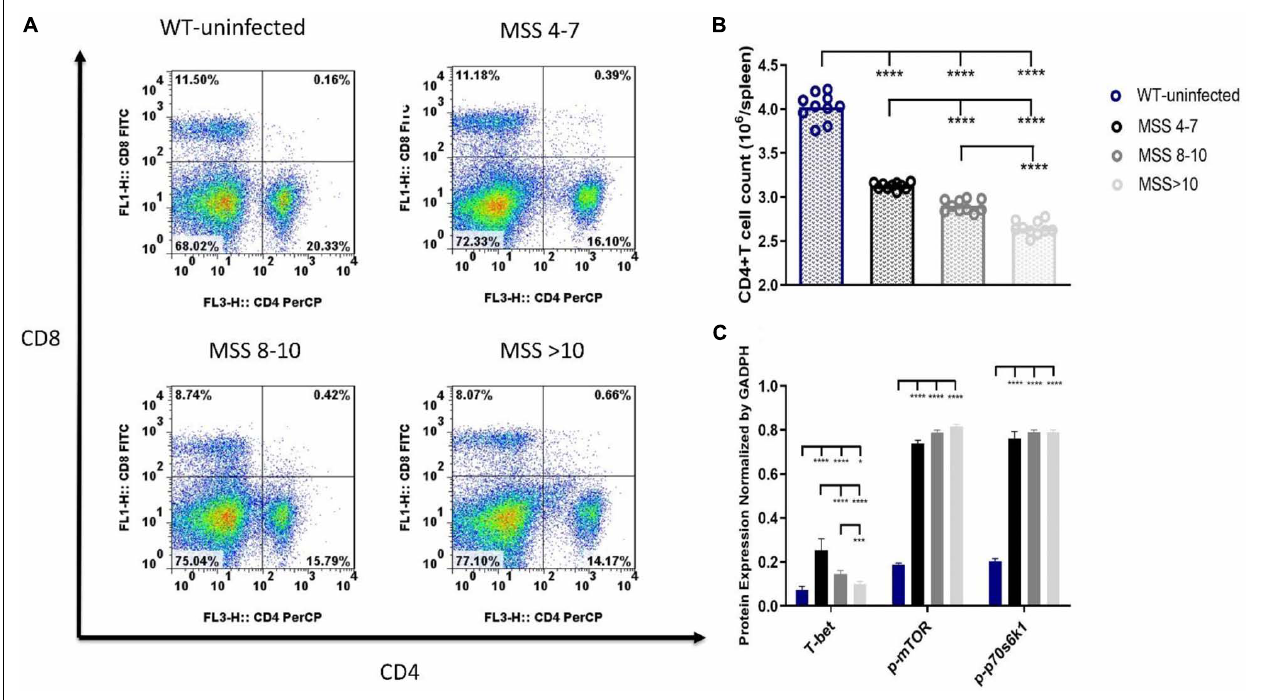
FIGURE 3 | CD4 + T cell count, T-bet expression and mammalian target of rapamycin (mTOR) pathway activation differed according to degrees of sepsis. Splenocytes were obtained at 12 h after Candida injection. (A,B) CD4 + T cells were sorted by flow cytometry analysis. Protein levels of T-bet, phospho (p)-mTOR and p-P70S6 (C) in CD4 + T cells. Levels of T-bet, p-mTOR and p-P70S6 in CD4 + T cells were quantified by western blotting. The amount of each protein level was normalized by GAPDH. Mean ± SD, 10 mice per group, analyzed by one-way analysis of variance multiple comparisons. * P < 0.05, *** P < 0.001, **** P < 0.0001. WT, wild type; (Summarization of the flow cytometry scatter plots was provided in Supplementary Material